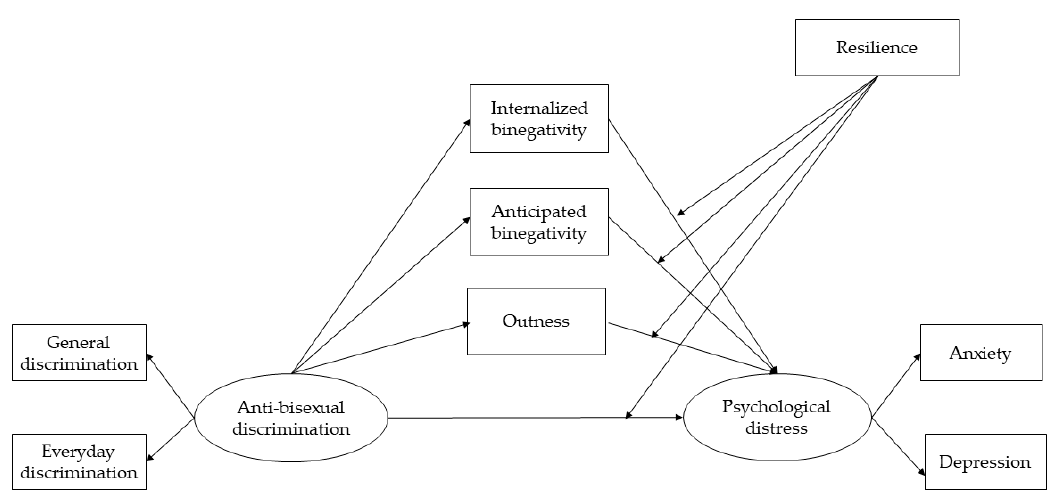
Figure 1. The moderated mediation model. Note: For simplification reasons, confounding variables were not reported in the model.